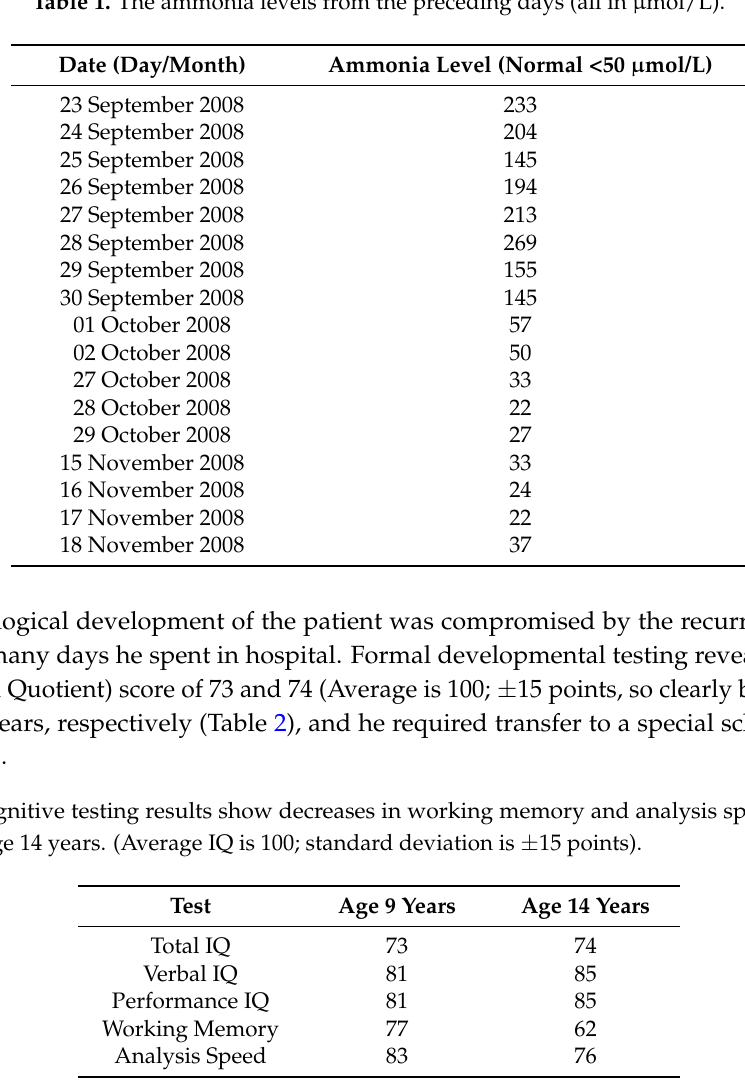
Table 1. The ammonia levels from the preceding days (all in µ mol/L).